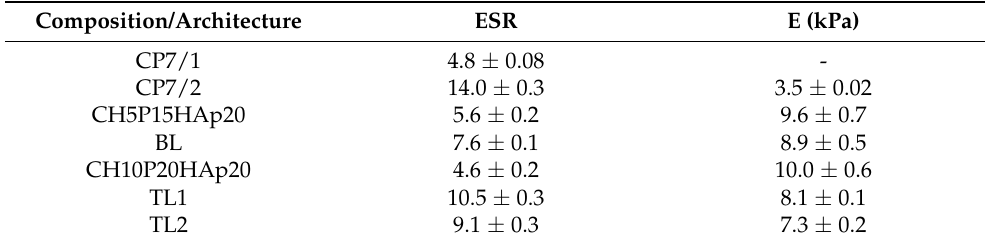
Table 3. Equilibrium swelling ratios (ESR) and Young’s modulus values of the investigated samples.